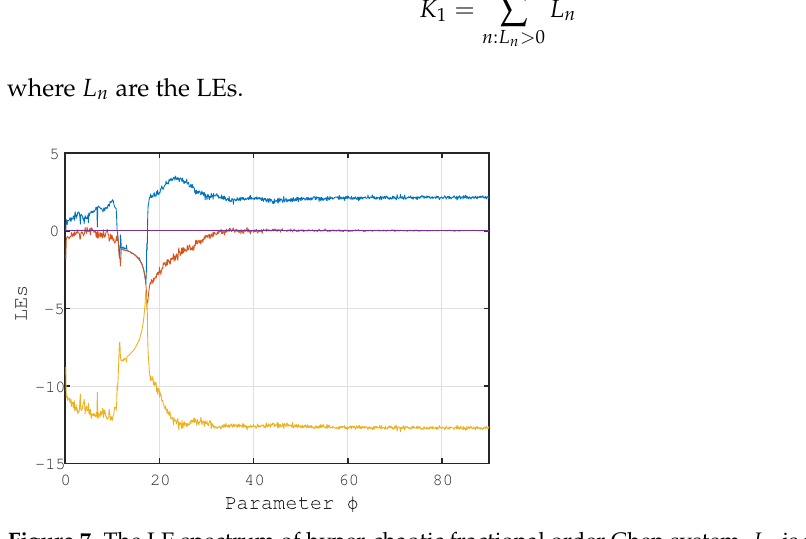
Figure 7. The LE spectrum of hyper-chaotic fractional order Chen system. L 1 is in blue color, L 2 in purple, L 3 in red, and L 4 yellow